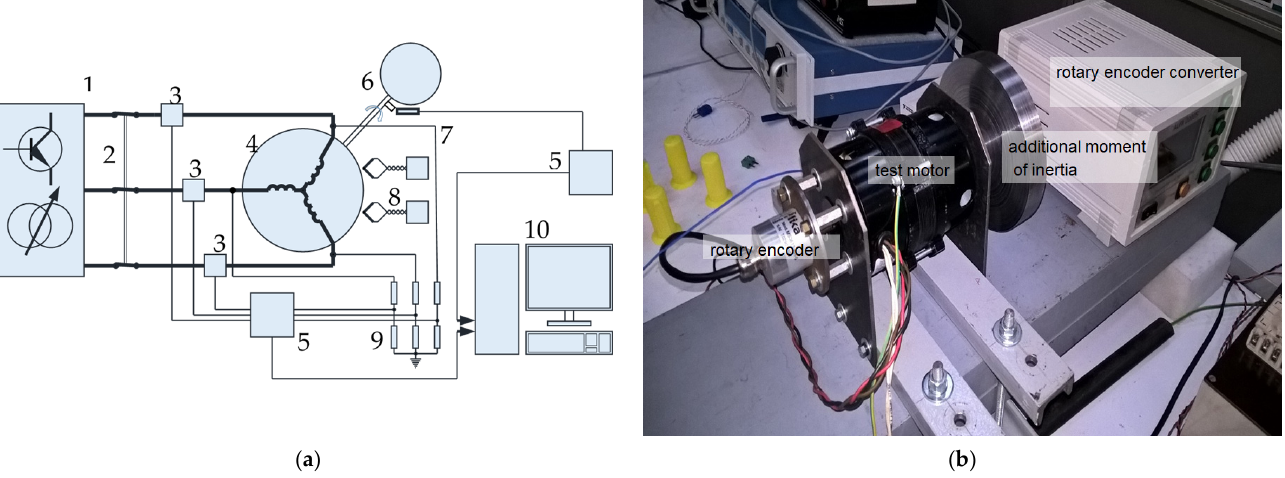
Figure 3. Measuring setup: block diagram ( a ): 1—power supply—alternatively an inductive regulator or a frequency converter, 2—switch, 3—current converter, 4—test motor, 5—measurements interface, 6—the mass of inertia, 7—shaft rotation sensor, 8—thermocouples with temperature meters, 9—resistance dividers for voltage measurement; experimental setup for testing the dynamics of a motor start-up with a disc with the additional moment of inertia mounted on the main shaft and an angular position encoder coupled with the second shaft end; on the right the encoder converter ( b